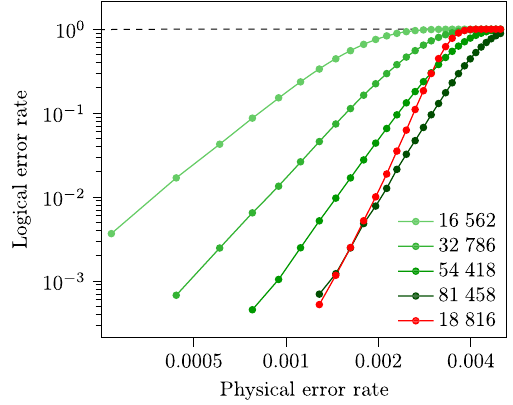
FIG. 18. Comparison of the [[8064,338,10]] l ¼ 2 f 8 ; 4 g subsystem semihyperbolic code (red), which has 8064 data FIG. 19. Comparison of the [[8064,338,10]] l ¼ 2 f 8 ; 4 g qubits and 10 752 ancillas, with L ¼ 4 , 6, 8, 9, and 10 subsystem subsystem semihyperbolic code (red), with L ¼ 5 , 7, 9, and toric codes (shades of blue), using a ð ZX Þ 20 schedule (no gauge 11 rotated surface codes (shades of green) using a ð ZX Þ 20 fixing) and a circuit-level depolarizing noise model. We fix the schedule (no gauge fixing) for the subsystem semihyperbolic number of logical qubits by plotting the probability that at least code and a ð ZX Þ 16 schedule for the rotated surface codes (both one of 169 independent copies of the subsystem toric codes schedules require 80 time steps). We use a circuit-level depola- 169 for the suffers a logical Z failure [i.e., we plot 1 − ð 1 − p rizing noise model. We fix the number of logical qubits by log Þ subsystem toric codes where p is the probability that a single log copies of the rotated surface code suffers a logical Z failure. The copy of the code suffers a logical Z error]. The total number of physical qubits (including ancillas) is given in the legend. The used. The black dashed line is the probability that at least one of black dashed line is the probability that at least one of 338 338 physical qubits would suffer a Z failure without error physical qubits would suffer a Z failure without error correction correction over the same over the same duration.